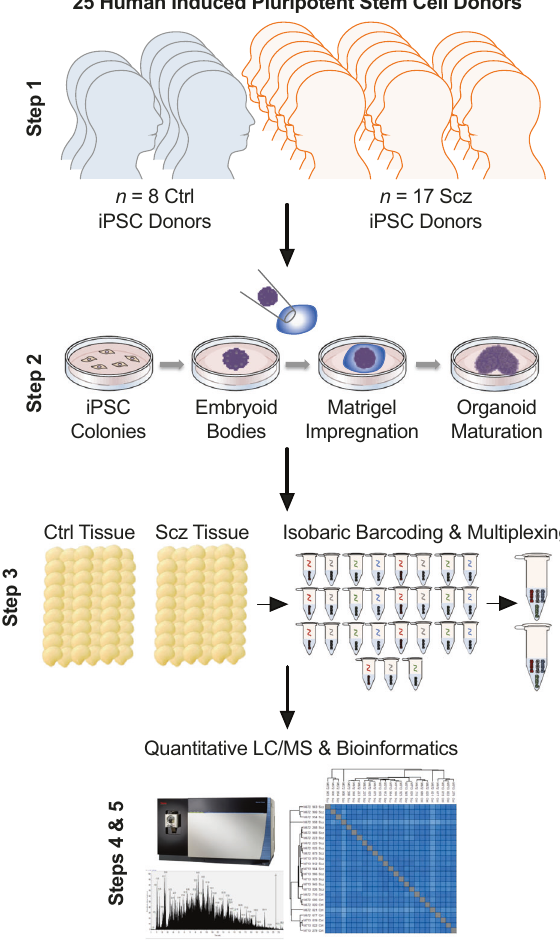
Fig. 1 Schematic of cerebral organoid and TMT-LC/MS analytical pipeline. Brie fl y, 25 distinct human iPSCs were obtained from both healthy Control (Ctrl) donors and Schizophrenia (Scz) patients. Each line represented a biologically unique sample from a speci fi c individual, and lines were predominantly obtained from NIH repositories. Following this, iPSCs were expanded and utilized to generate patient-derived cerebral organoids that mimic the 1 st trimester of brain assembly (see Methods, [17, 87] for protocol information, and [1] for our previous application of 3D Scz patient-derived organoids). This process involved dissociating iPSC colonies to generate 3D embryoid body aggregates that could be pushed towards a neural fate via chemically minimalist media cocktails [17, 87]. Following neural induction, organoids were implanted into a matrigel droplet as a scaffold to support tissue expansion and (broadly consistent with our prior study [54]) maturated to a primary endpoint of 35-40 DIV. Following this, samples were individually subjected to protein lysis and tryptic-based enzymatic digestion. For proteomic analysis of cerebral organoids, peptides were isobarically barcoded using TMTpro 16-Plex chemistry that allowed samples to be multiplexed for simultaneous detection of different samples via liquid chomatography – mass spectrometry (LC/MS). This allowed up to 15 samples ( + 1 pool) to be condensed into a single tube for simultaneous detection via LC/MS analysis, resulting in a total of 27 samples ( n = 25 human donor organoids, + n = 2 internal reference pools). Bioinformatics were subsequently conducted in accordance with the parameters described in our Methods as well as two prior manuscripts that have incorporated LC/MS proteomic analysis of human-derived organoid samples [1,